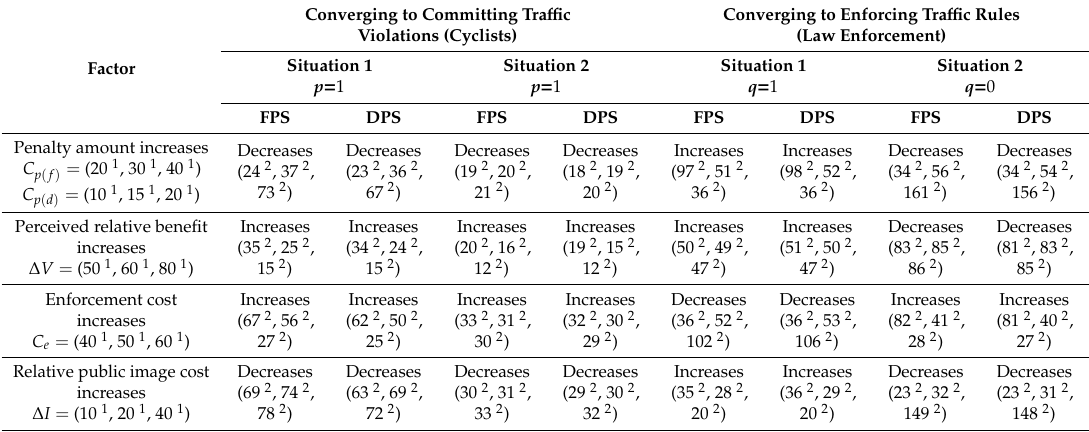
Table 8. Converging speed changes of the probabilities of tra ffi c violations and enforcing tra ffi c rules in Situations 1 and